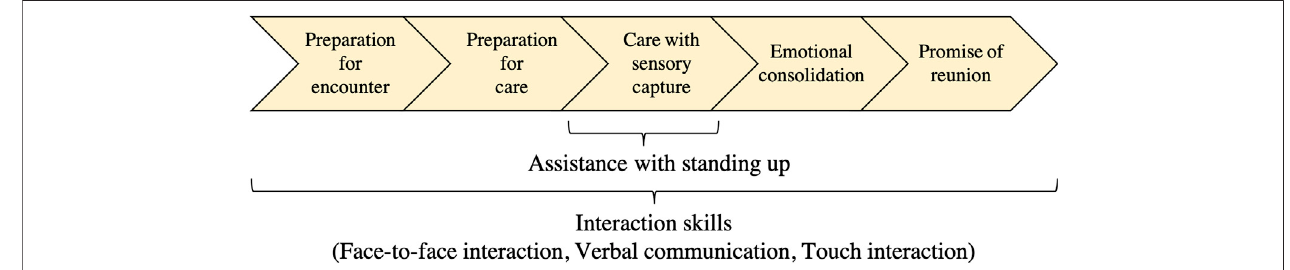
FIGURE 2 | Five consecutive stages in Humanitude and related